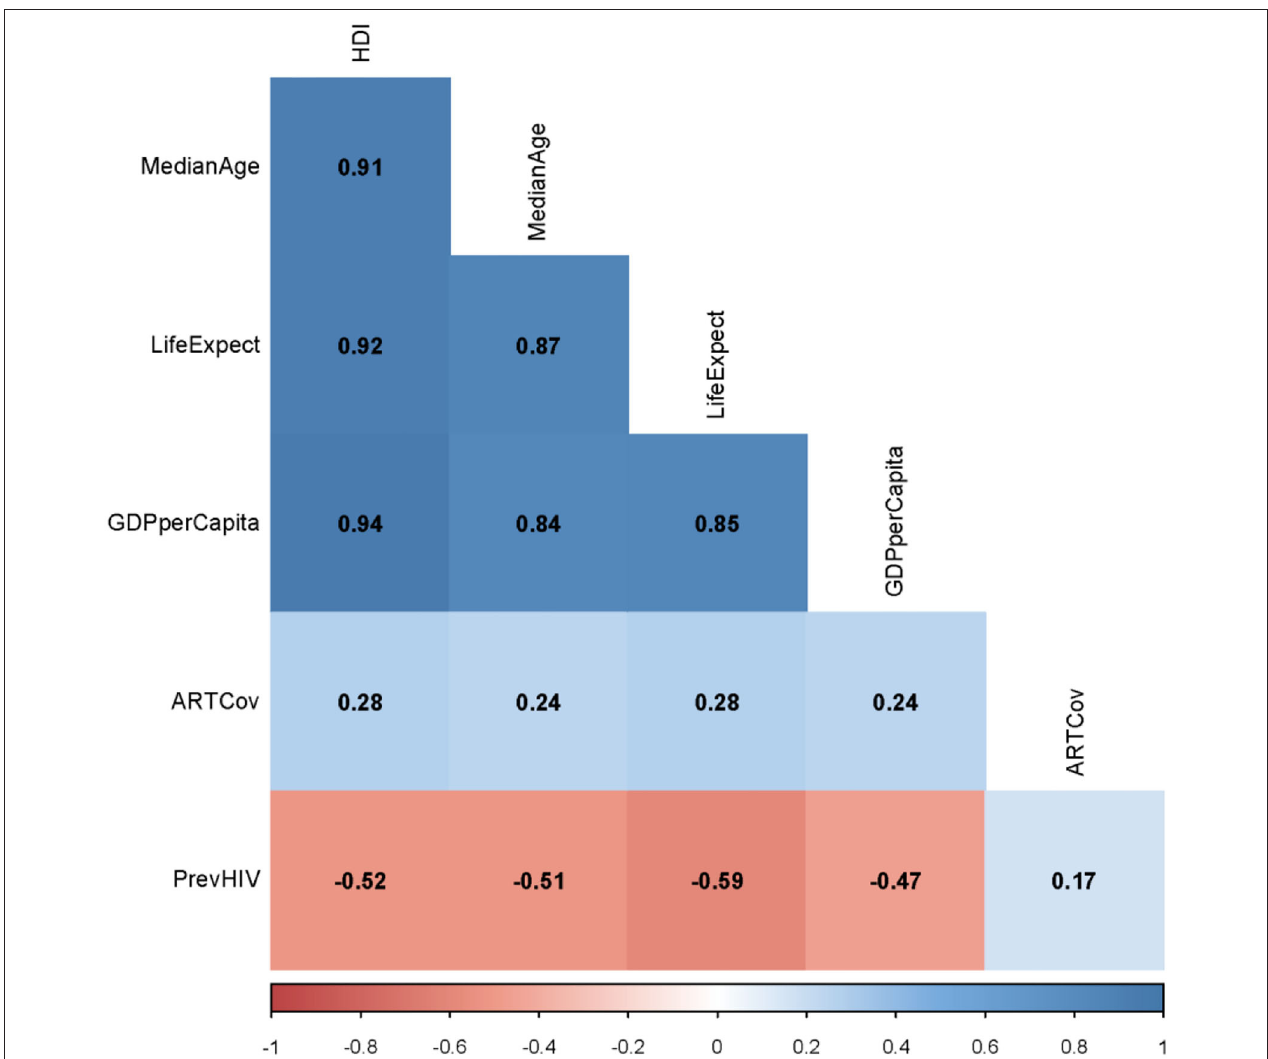
FIGURE 3 | Spearman ρ between each of two studied continuous variables from the original dataset. HDI, human development index; MedianAge, median age; LifeExpect, life expectancy; GDPperCapita, gross domestic product per capita; PrevHIV, prevalence of HIV/AIDS in women aged 15–49 years; and ARTCov, antiretroviral therapy coverage (% of people living with